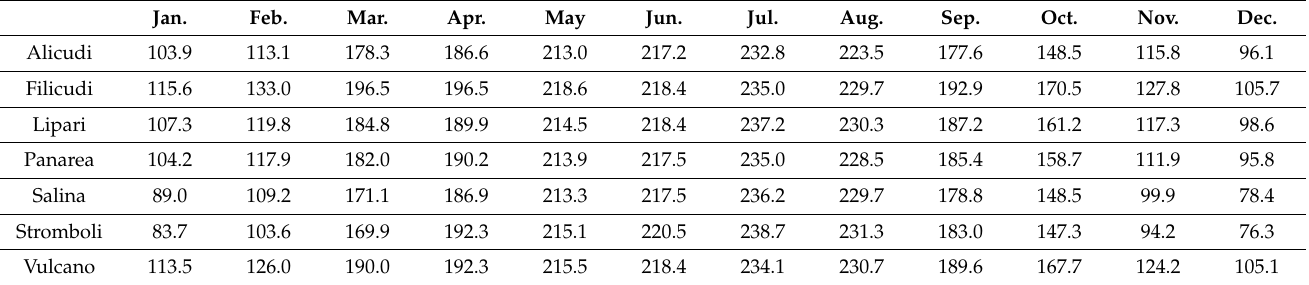
Table A6. Monthly solar radiation data [kWh/m 2 ] for each island